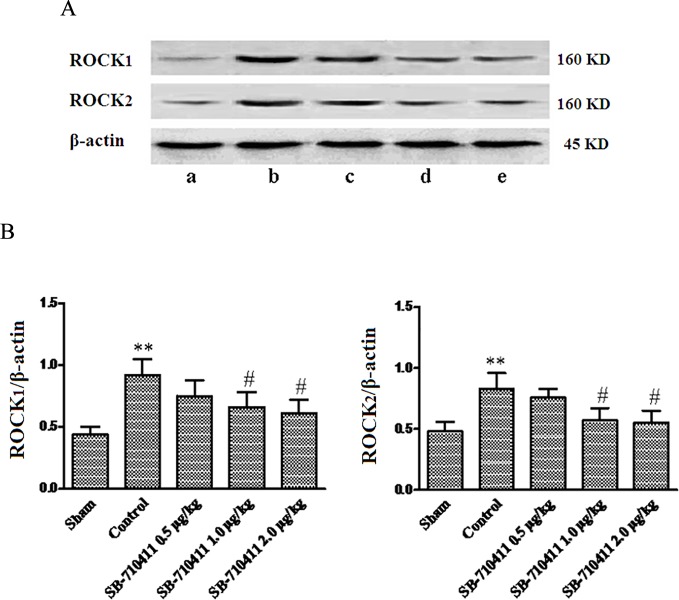
Effect of SB-710411 on protein expressions of ROCK1 and ROCK2 in rat myocardium injured by ischemia/reperfusion.A. ROCK1 and ROCK2 proteins were detected by Western blot method. β-actin was used as the loading control. B. Densitometric quantification of ROCK1and ROCK2 protein expression. a: Sham; b: Control; c ~ e: 0.5, 1.0 and 2.0 μg/kg SB-710411. Results are expressed as mean ± SD (n = 4 per group). **p < 0.01 vs. the sham group; #p < 0.05, ##p < 0.01 vs. the control group.